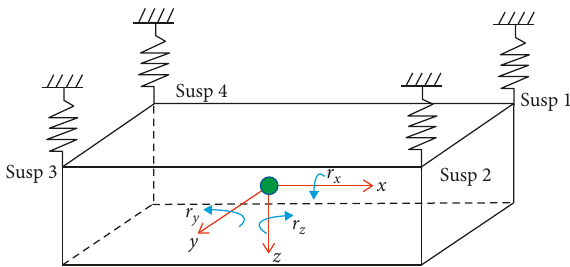
Figure 9: Schematic representation of the UCE coordinate